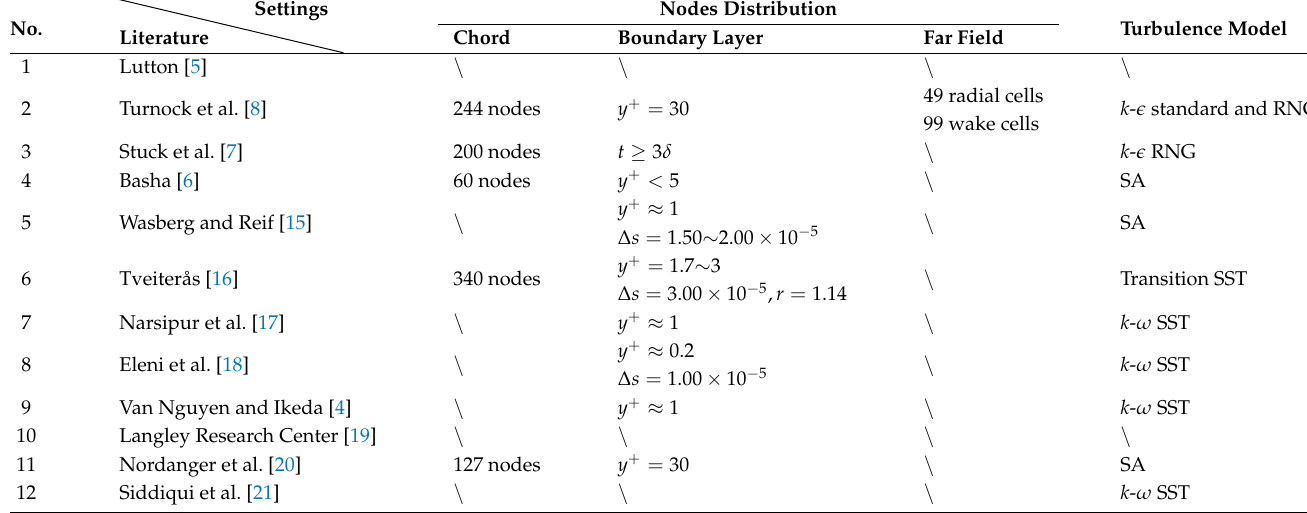
Table 2. Mesh properties studies in literature: node distributions and turbulence